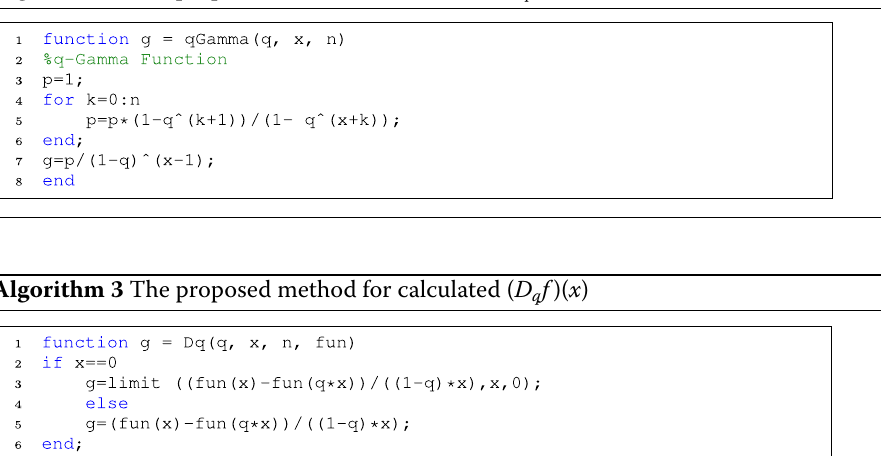
Algorithm 2 The proposed method for calculated Γ q ( x )